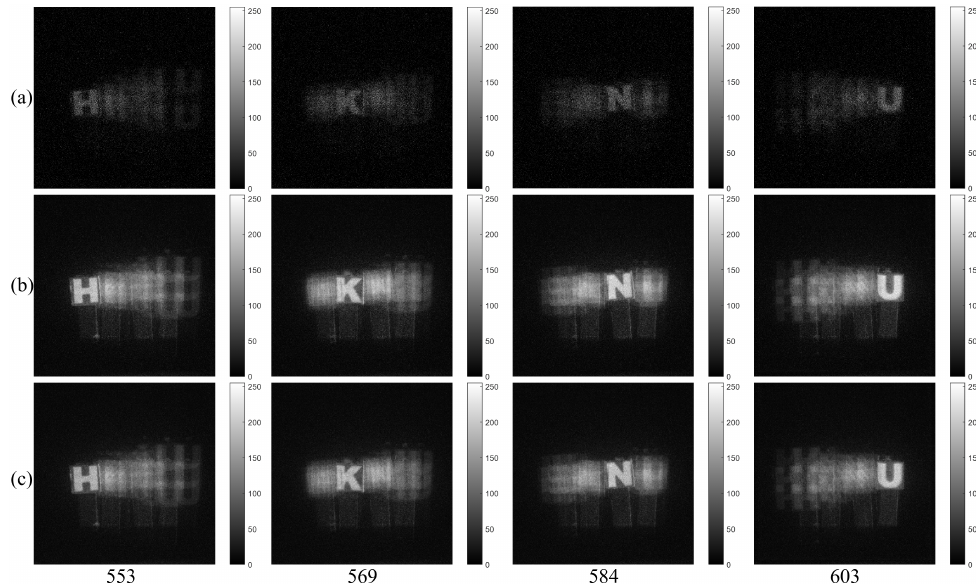
Figure 12. 3D images under photon-starved conditions of HKNU objects with 1% photon ratio and various spatial periods at reconstruction depths by ( a ) the single observation photon counting images ( b ) N = 100 observation photon counting images by MLE and ( c ) N = 100 observation photon counting images by MAP, respectively.